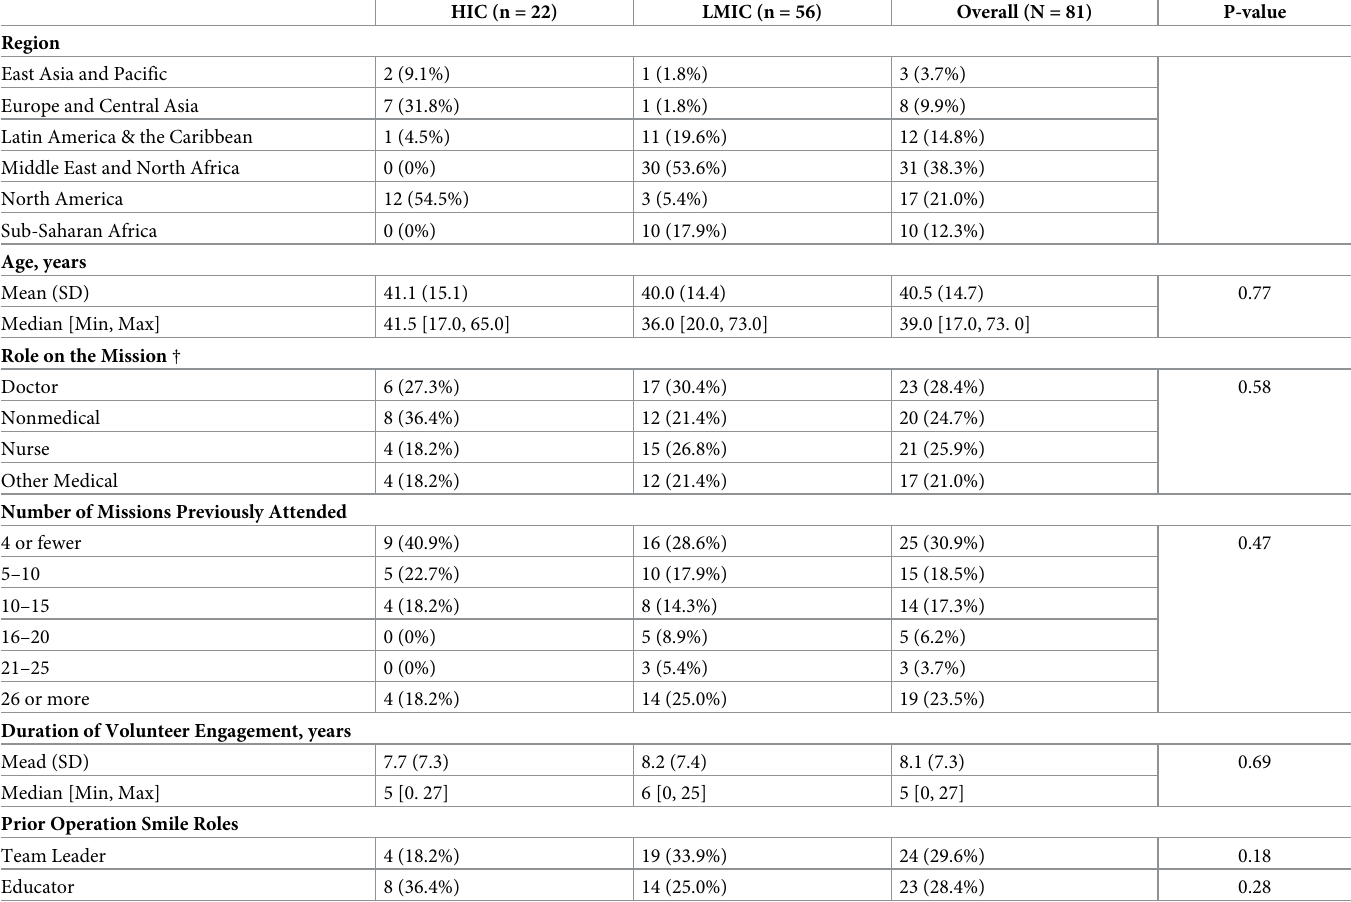
Table 1. Demographics of survey respondents from high income countries (HICs) and lower- and middle-income countries